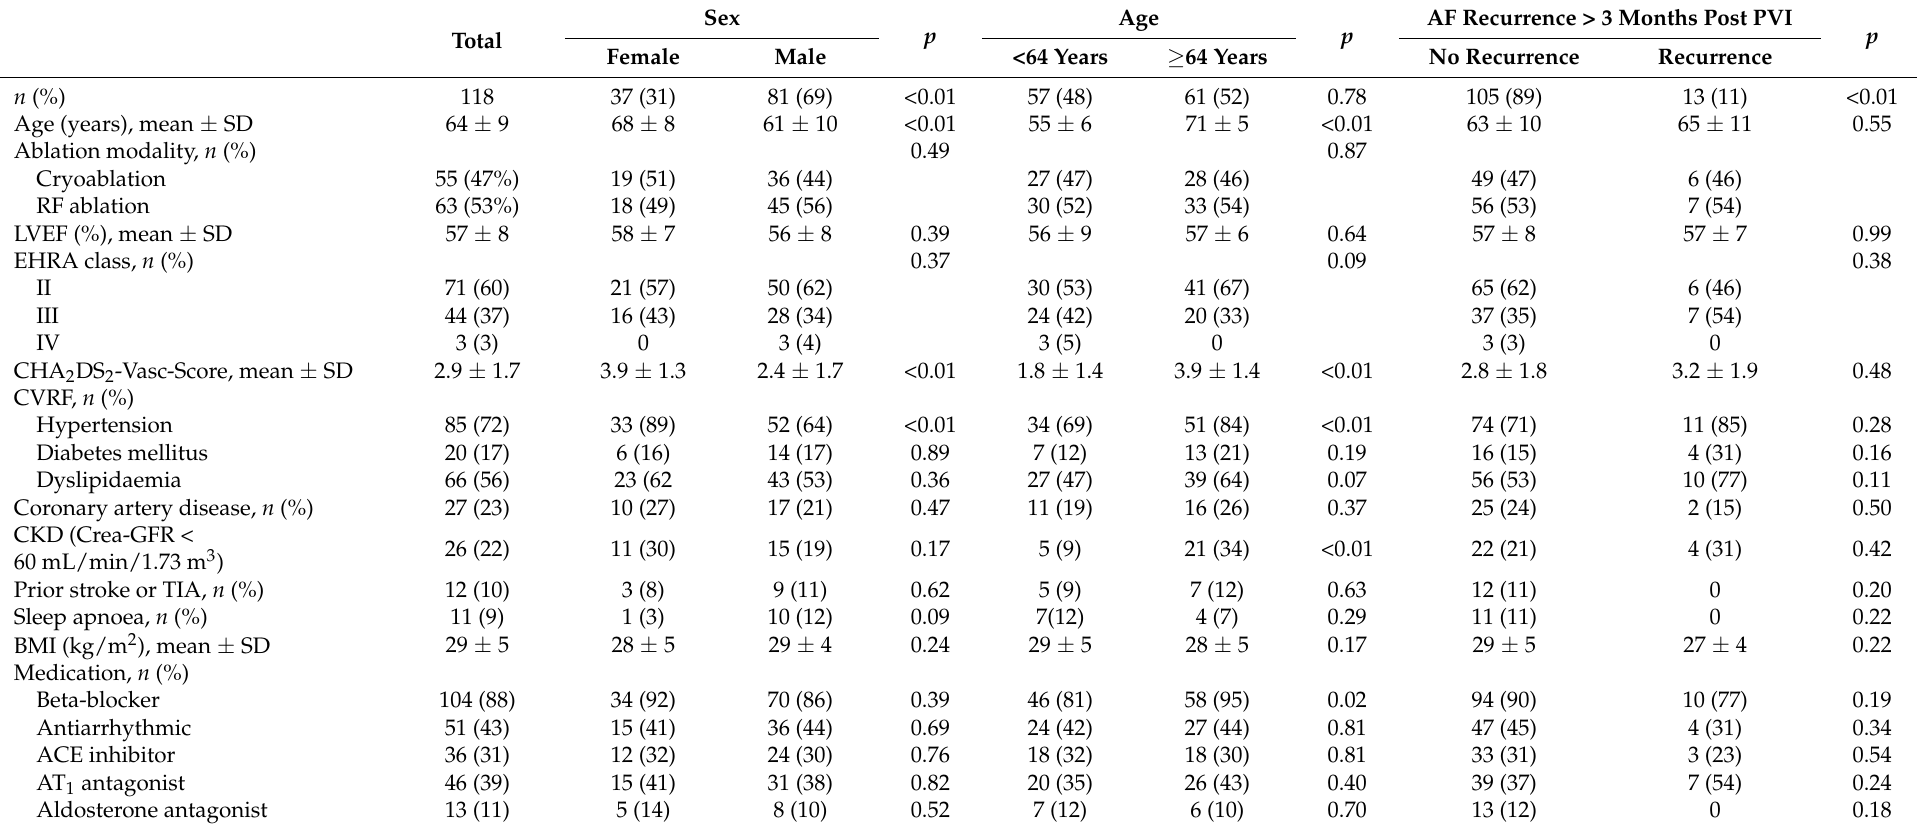
Table 1. Baseline